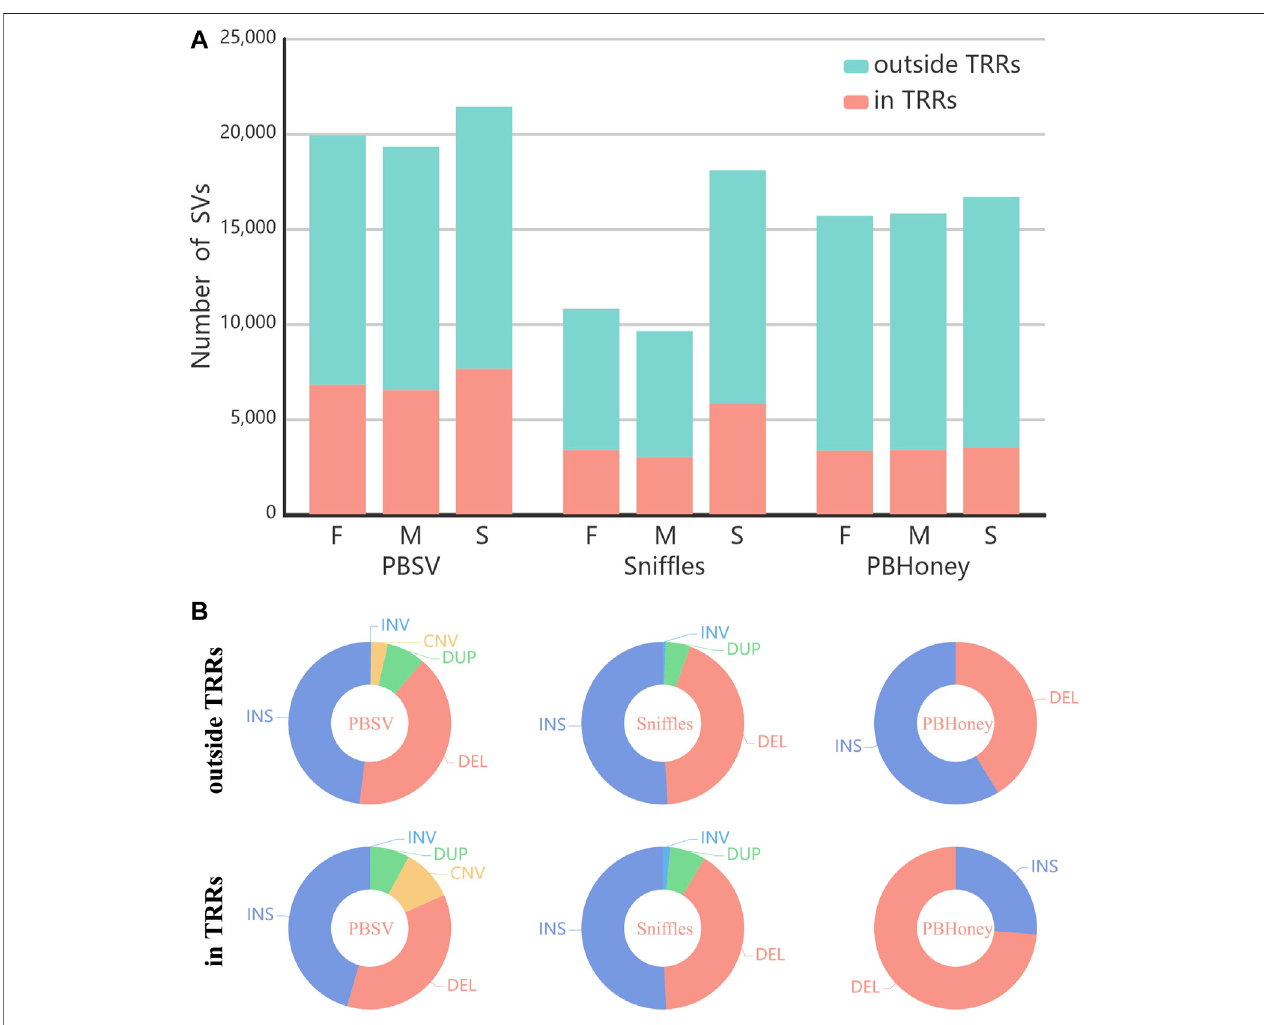
FIGURE 1 | (A) The number ofSVs in the callsets of the parents and the son (F, Father; M, Mother; S, Son) detected by PBSV, Snif fl es and PBHoney. (B) The type distribution of the whole callsets of the trio detected by three pipelines in/outside TRRs.